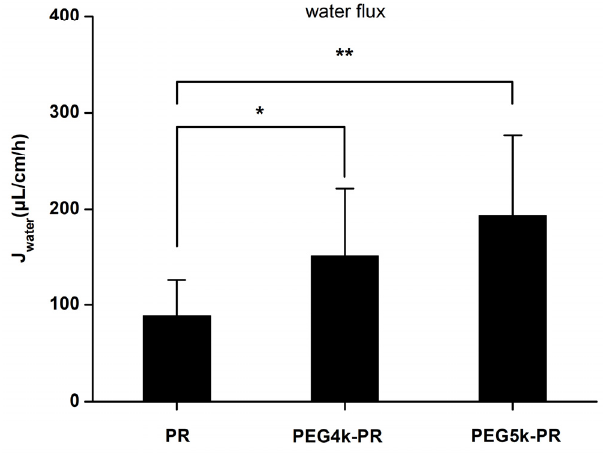
Figure 9. Water flux ( J water ) corrected by PR, PEG4k-PR, and PEG5k-PR at 56 µ M during intestinal perfusion. Data are shown as mean ± SD, n = 6; * p < 0.05 and ** p <